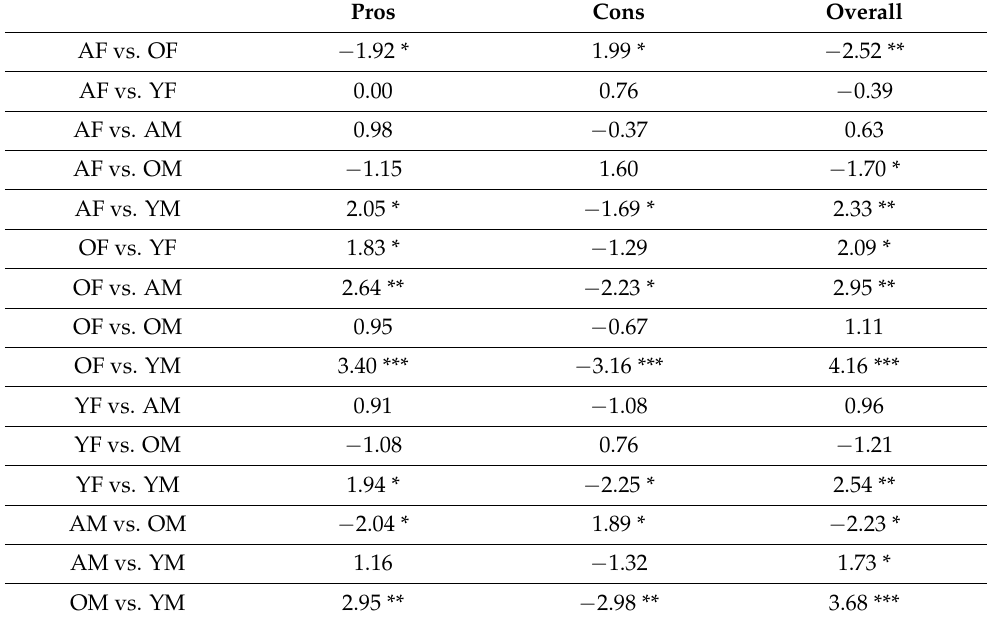
Table 11. Results of pairwise comparison using Dunn’s test (z-statistic and p -values) for attitudes towards preparedness ( α = 0.05). Grey cells indicate significant differences between subgroups for all the